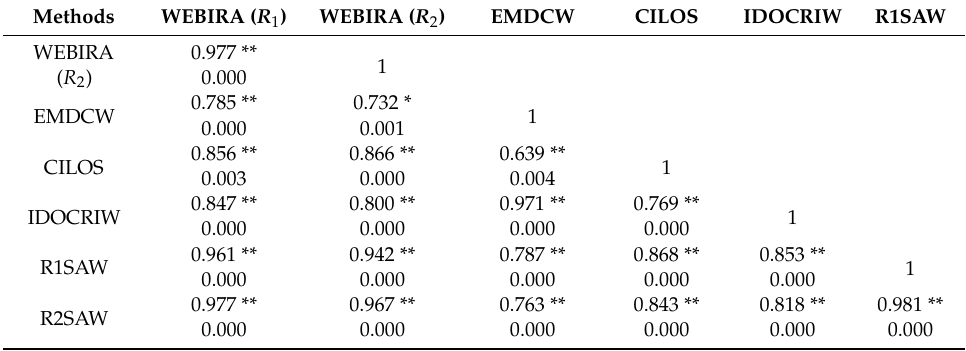
Table 10. Values of Spearman correlation coe ffi cients between countries ranks calculated by seven methods (the first row) and p -values (the second